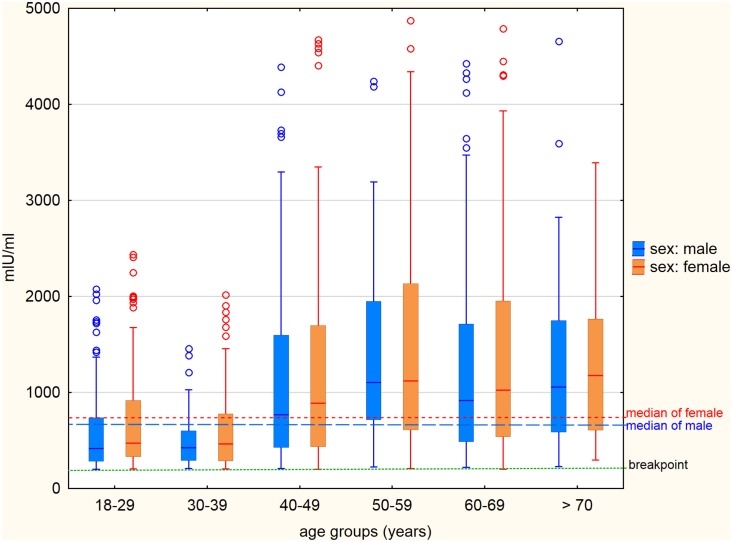
Concentration of IgG antibodies against measles in individual age groups in seropositive men and women.The line inside the box shows the median for each group, the lower and the upper edge of the box indicates 25% and 75% percentile, the distance between them (IQR—inter-quartile range) is a measure of the dispersion of values. The ends of the line segments indicate 1.5 times the IQR and values that occur outside these boundaries, are considered outliers.